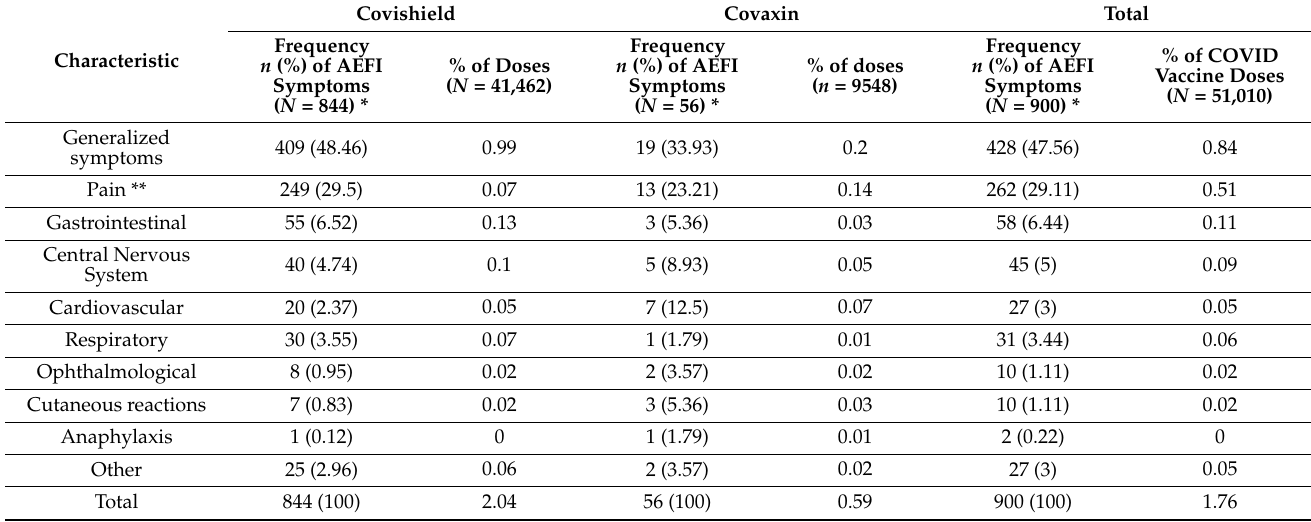
Table 3. System-wise distribution of AEFI reported with COVID-19 vaccination.